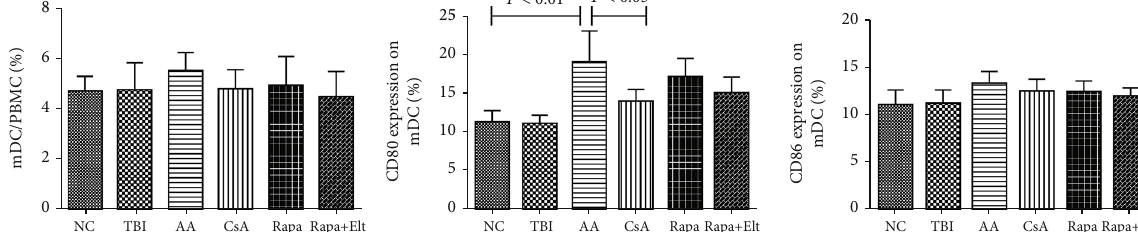
Figure 5: E ffi cacy of rapamycin combined with eltrombopag on mDC. The numbers of mDC and the expression of CD80 and CD86 on mDC in the CsA group, the Rapa group, and the Rapa+Elt group are all lower than that in the AA group but with no statistical signi fi cance except CD80. And the expression of CD80 on mDC was downregulated in the CsA group, the Rapa group compared with the AA group, but there is statistical signi fi cance only in the CsA group ( P < 0 : 05 ). There was no signi fi cant di ff erence between the Rapa and CsA groups on the function of mDC. When Rapa is combined with Elt, the expression of CD80 and CD86 are downregulated more compared to the Rapa group, but there is no statistical signi fi